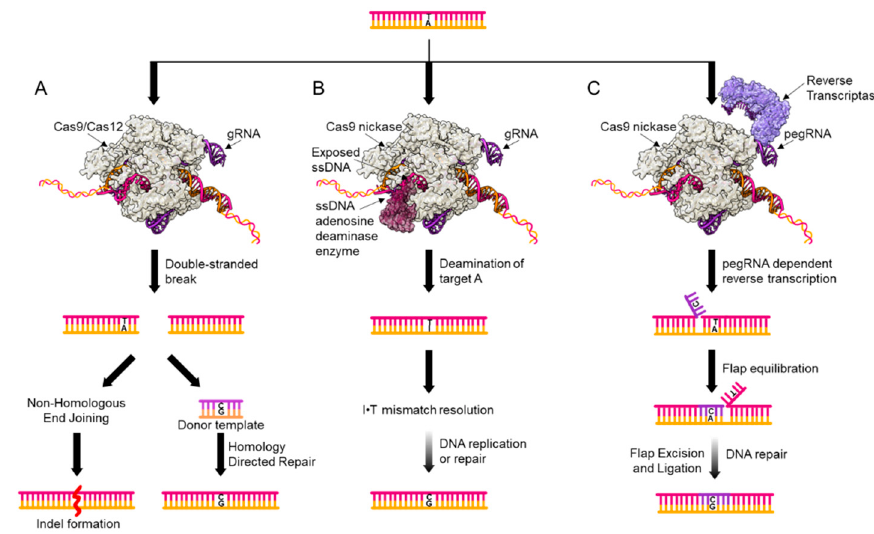
Figure 2. Genome editing tool kit. Currently available tools for point mutation introduction are shown, with a A • T to G • C shown as an example. ( A ) Double-stranded DNA break (DSB) introduction by RNA-guided Cas enzymes. The Cas endonuclease is programmed to bind and cut at a genomic locus of the researcher’s choosing by the sequence of the gRNA. Following DSB introduction, two repair pathways compete for resolution of the DSB, resulting in both indel formation and single nucleotide variant (SNV) introduction. ( B ) Base editors facilitate SNV introduction by chemically modifying a target DNA nucleobase into a uracil or inosine (inosine shown as an example). These non-canonical DNA bases are then processed by the cell, resulting in SNV introduction. ( C ) Prime editors use a 3 ′ extension on the gRNA as a template for a reverse transcriptase. Following the introduction of this sequence directly into the genome (light purple), flap resolution by cellular repair factors will remove the original genomic sequence to yield a mismatch, which is then processed by cellular repair factors to yield the SNV of interest.